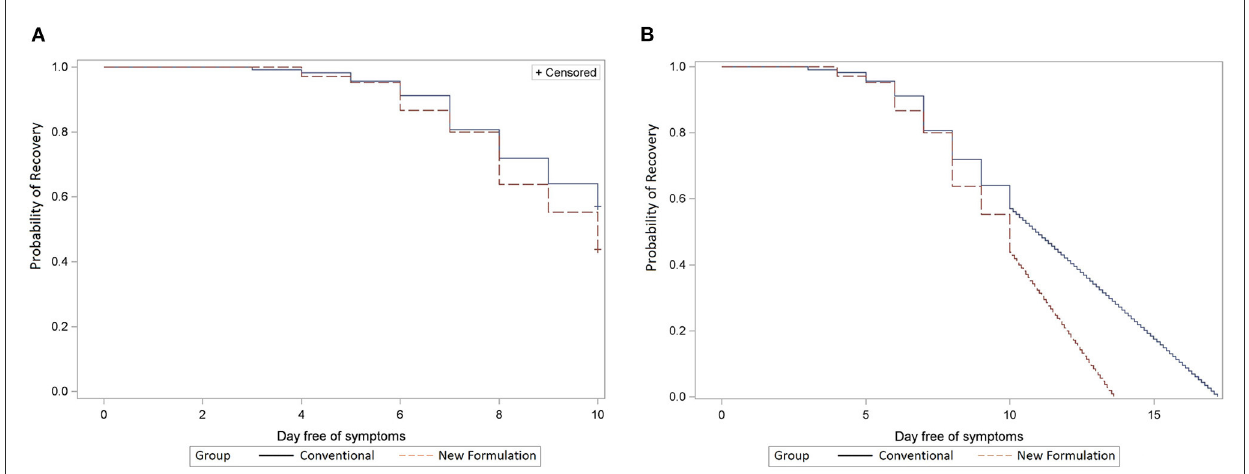
FIGURE2 (A) Remission of first infection episode. Comparison of new (dashed line, A + B) vs. conventional (solid line, C + D) formulations in ITT population; x-axis: day free of symptoms; y-axis: the probability of recovery (Kaplan–Meier analysis). (B) Remission of first infection episode extrapolated until full recovery. Comparison of new (dashed line, A + B) versus conventional (solid line, C + D) formulations in ITT population; x-axis: day free of symptoms, y-axis: the probability of recovery (Kaplan–Meier analysis).